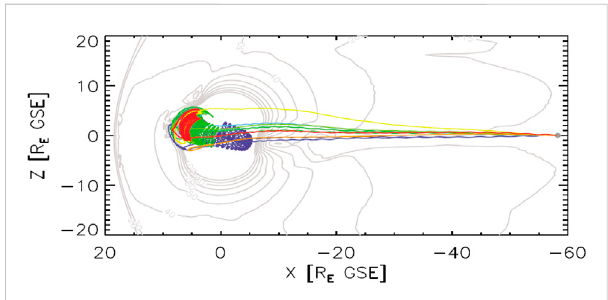
FIGURE 8 MHD Open Global Geospace Circulation Model simulations (backward particle tracing) suggest how heavy ions, observed in the Moon environment during high geomagnetic activity events (at X GSE ≈ − 60 R E ), can originate from the inner magnetosphere. Earth- to-Moon transport times are ~2 – 3 h (From: Poppe et al., 2016).